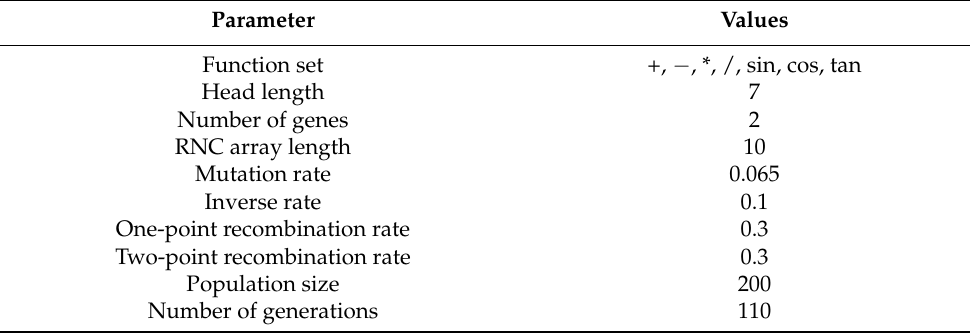
Table 5. GEP model configuration and parameters.